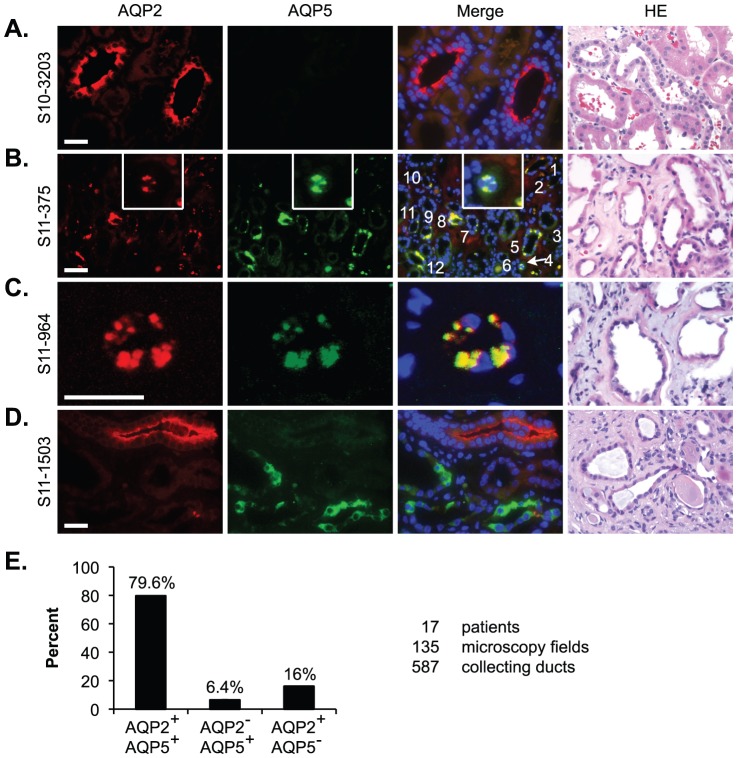
AQP5 is pathologically expressed and colocalizes with AQP2 at the perinuclear region in patients with DN.(A–D) Representative IF images of kidney biopsies from a patient with MCD showing no detectable AQP5 (A), from two patients with DN showing AQP5 colocalization with AQP2 at perinuclear region (B–C), and from a patient with DN showing diffuse AQP5 without AQP2 in the same cells (D). There are 12 AQP2+AQP5+ tubules in B. Three detached cells are shown in the insert. Hematoxylin/eosin staining verified no significant pathological changes in the tubules of the MCD samples, but various tubular abnormalities in all of the DN samples (see text for details). (E) Summary of the relative abundance of the three types of tubules from 17 patients with DN. Scale bar: 50 µM.